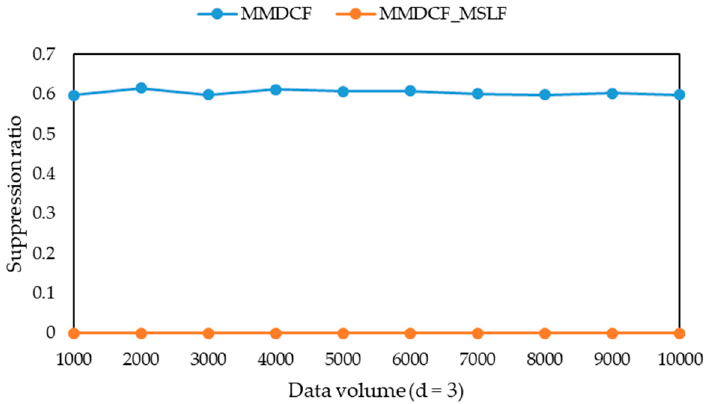
Figure 14. The additional information loss of MMDCF and MMDCF-MSLF with different data volumes ( d = 3).